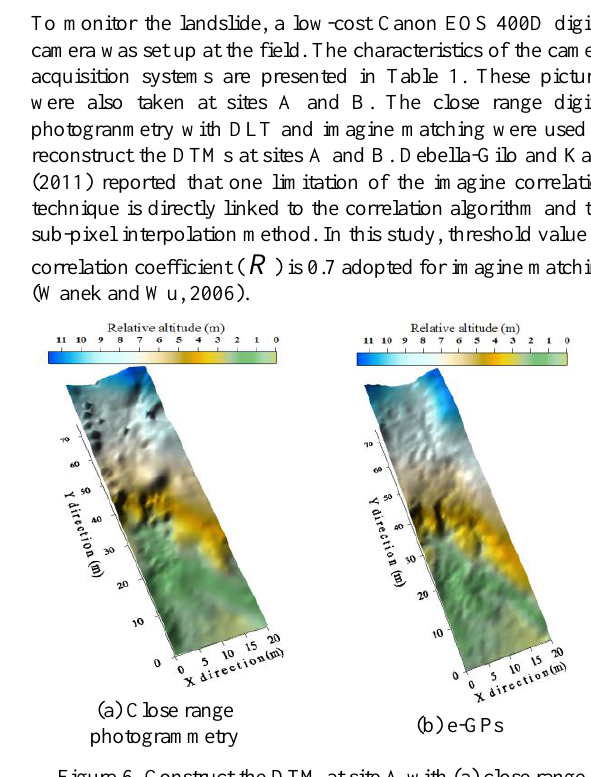
Figure 6. Construct the DTM at site A with (a) close range photogrammetry and (b) e-GPS